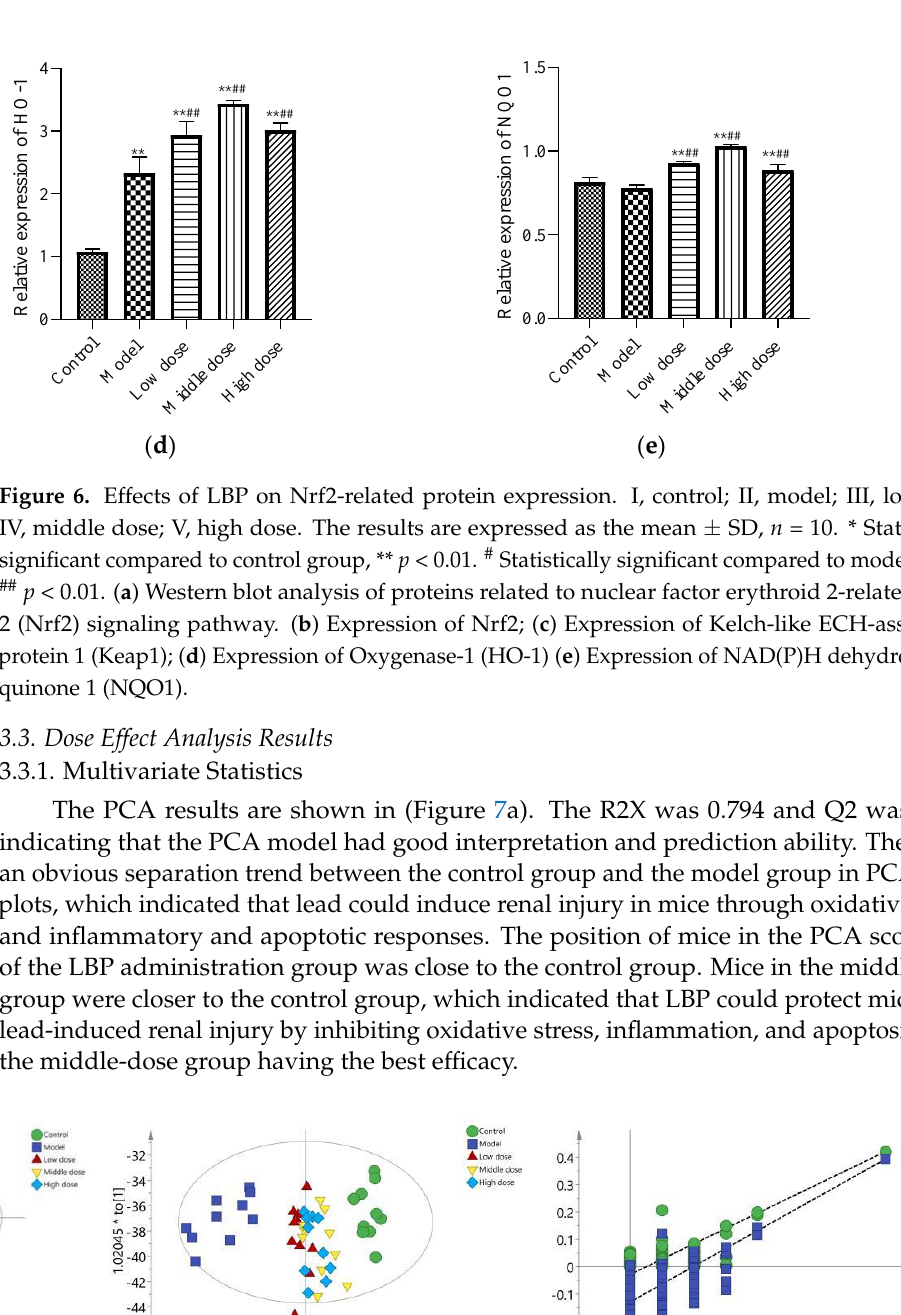
Figure 6. Effects of LBP on Nrf2-related protein expression. Ⅰ , control; Ⅱ , model; Ⅲ , low dose; Ⅳ , middle dose; Ⅴ , high dose. The results are expressed as the mean ±SD, n = 10. * Statistically signifi- cant compared to control group, * p < 0.05, ** p < 0.01. # Statistically significant compared to model group, # p < 0.05, ## p < 0.01. ( a ) Western blot analysis of proteins related to nuclear factor erythroid 2-related factor 2 (Nrf2) signaling pathway. ( b ) Expression of Nrf2; ( c ) Expression of Kelch-like ECH-associated protein 1 (Keap1); ( d ) Expression of Oxygenase-1 (HO-1) ( e ) Expression of NAD(P)H dehydrogenase, quinone 1 (NQO1).